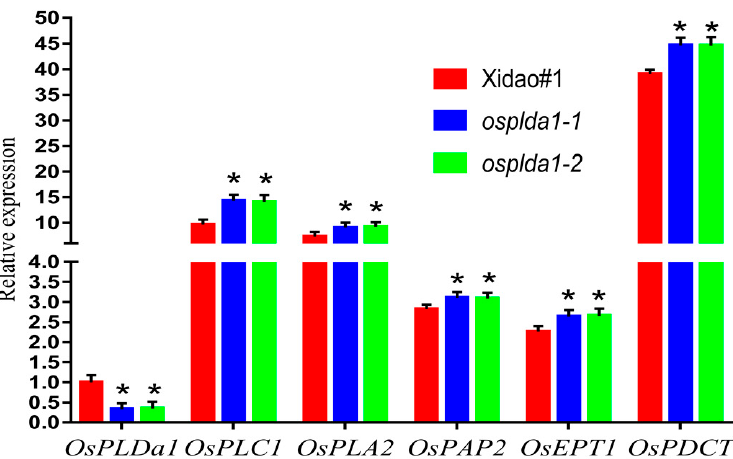
Figure 2. Relative expression level of genes governing the dual metabolic pathway of LPL and phytic acid in rice grains. The expression values of all candidate genes were relative to OsPLD α 1 whereas, OsActin was utilized as an internal reference. Data are represented as means with standard deviation, and asterisk(s) represents the significant difference (Duncan’s test, * p < 0.05)